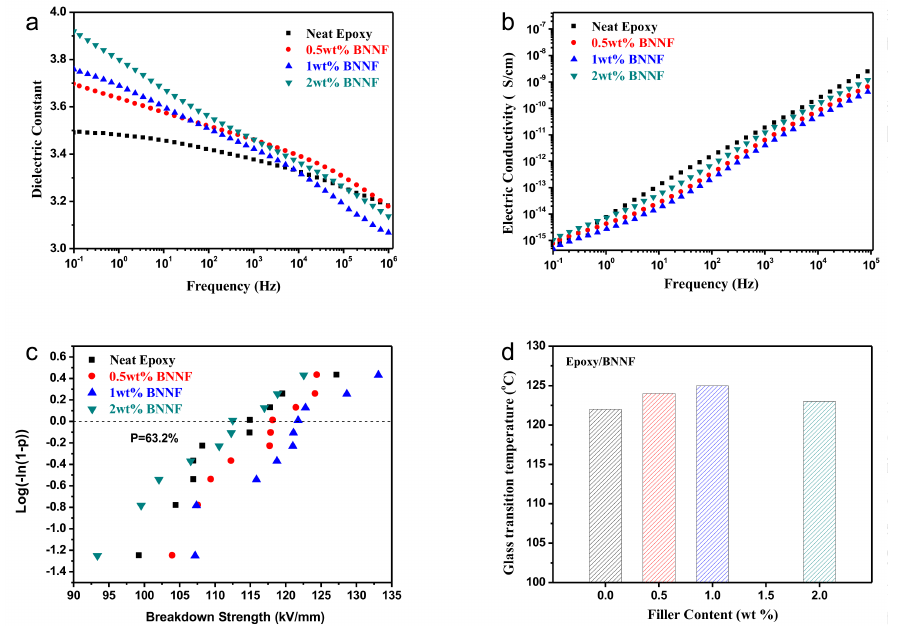
Figure 4. ( a ) Dielectric permittivity( ε ’) and ( b ) electric conductivity dependence on frequency and filler loading for the epoxy composite film with different mass fraction of BNNF at room temperature. ( c ) Weibull plots of breakdown strength of Epoxy/BNNF composite film. ( d ) DSC curves of four samples of different mass fraction of